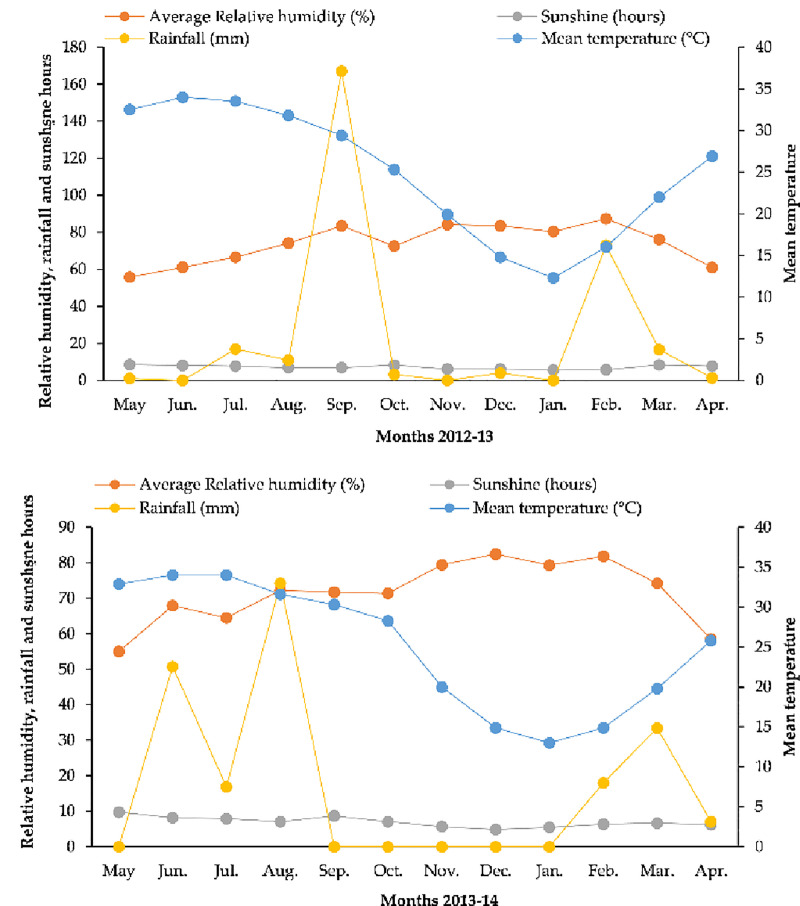
Weather data of the experimental site during both experimental years.